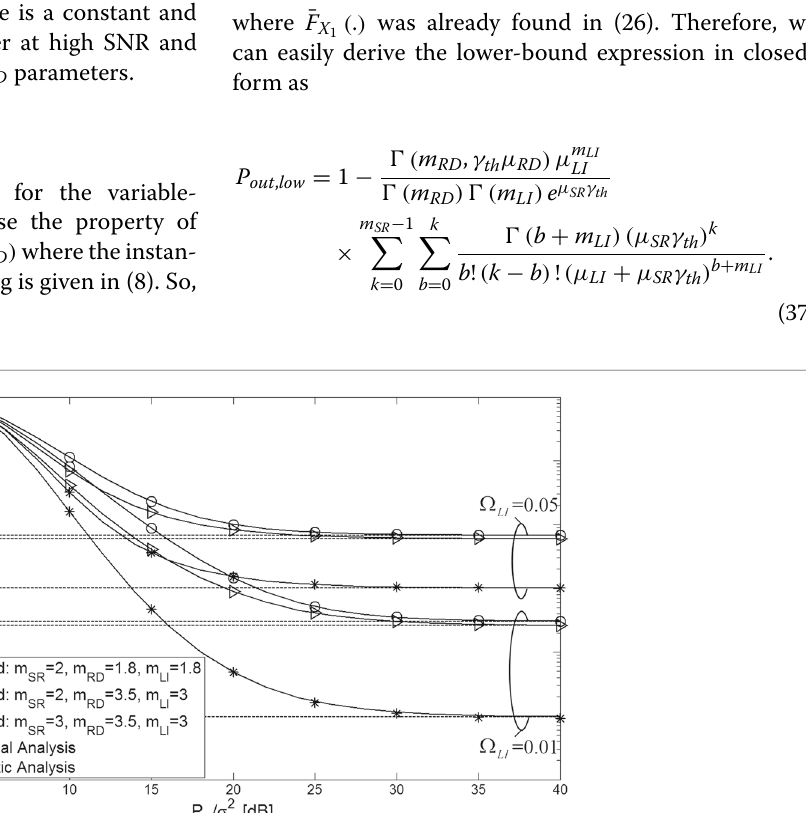
By substituting (34) in (11), the asymptotic outage prob- ability is obtained in closed-form as